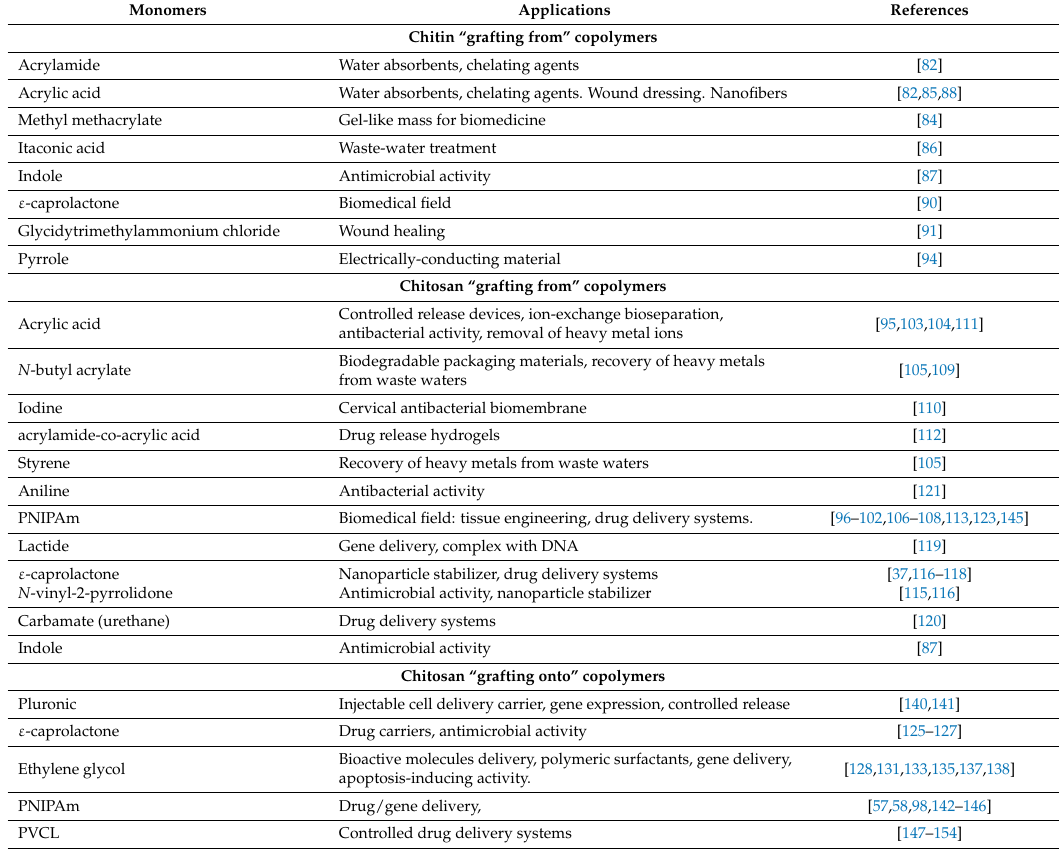
Table 1. Main monomers used for derivatization of chitin and chitosan by grafting copolymerization.